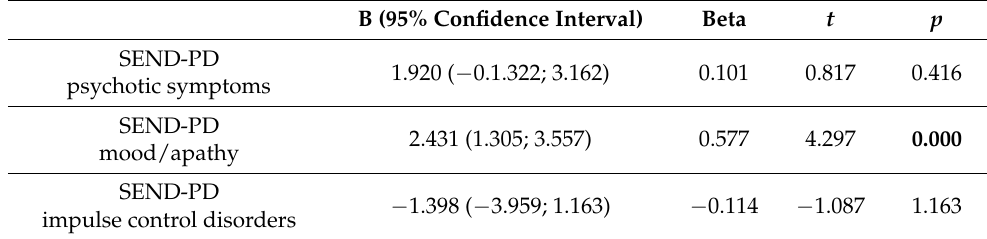
Table 3. Multiple linear regression analysis of factors contributing to PwP’s HR-QoL (PDQ-8, n = 87); R = 0.600; R 2 = 0.360; adjusted R 2 = 0.336.